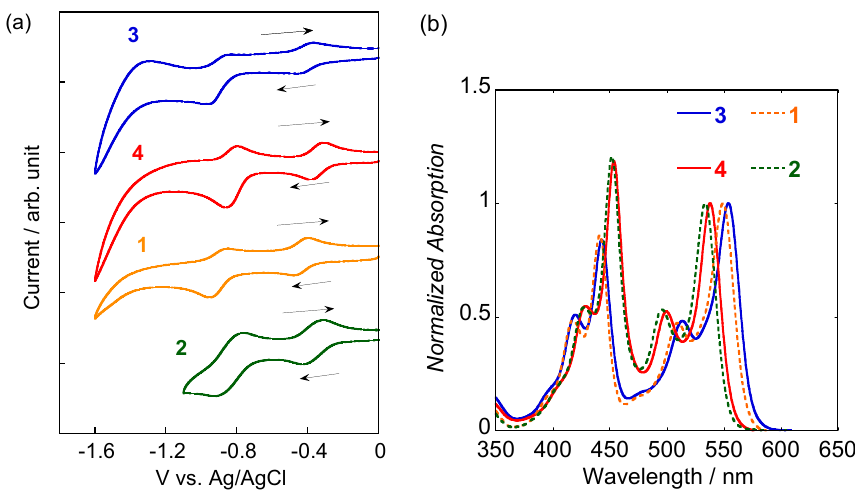
Figure 3. Cyclic voltammograms ( a ) and UV-vis absorption spectra ( b ).